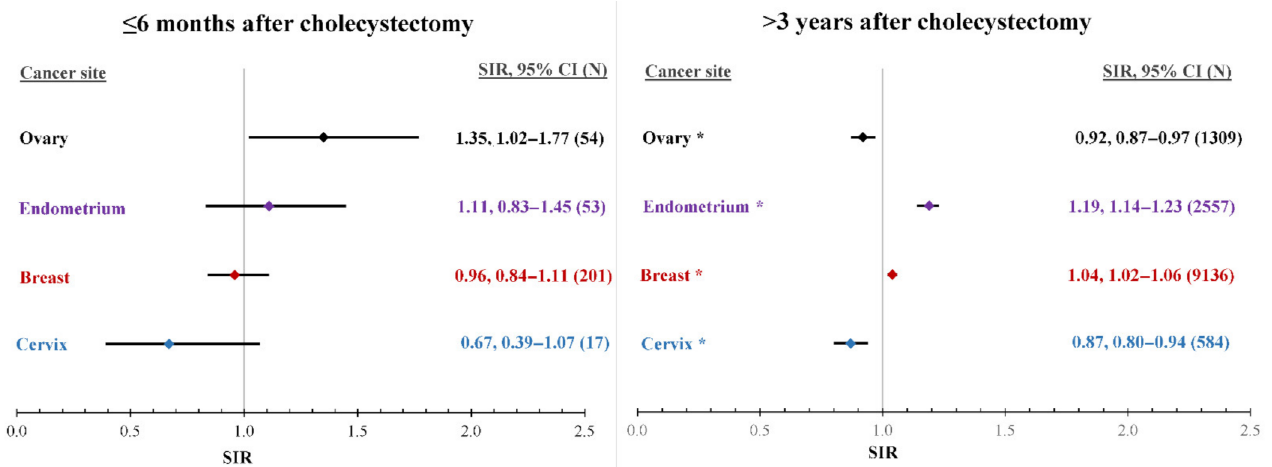
Figure 1. Relative risk of female cancers after cholecystectomy. Left panel: During the first six months after surgery. Right panel: Diagnosed more than three years after cholecystectomy. *: Probability value smaller than 0.0125 (0.05 divided by the four investigated female cancer sites); N: number of cancer patients; SIR: standardized incidence ratio; CI: confidence